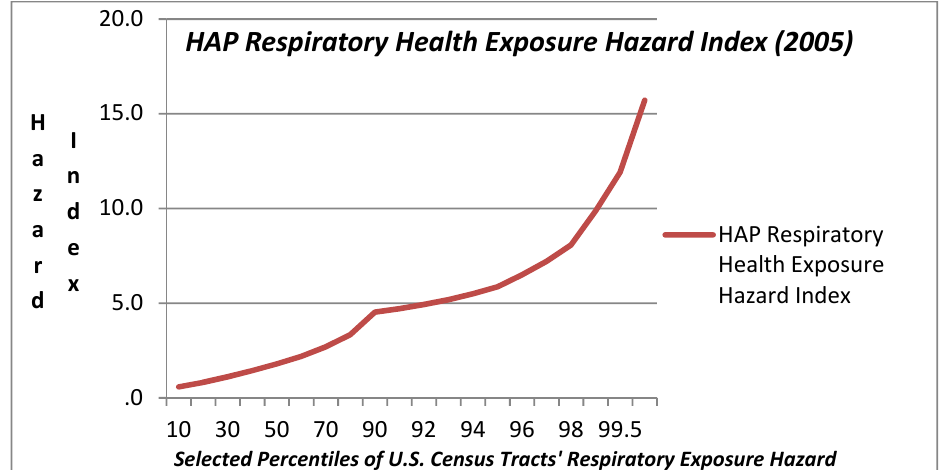
Figure 3. Hazardous Air Pollution (HAP) Respiratory Health Exposure Hazard Index (2005) Values at Selected Percentiles for U.S. Census Tracts (U.S. E.P.A. National Air Toxics Assessment, 2005) [44].